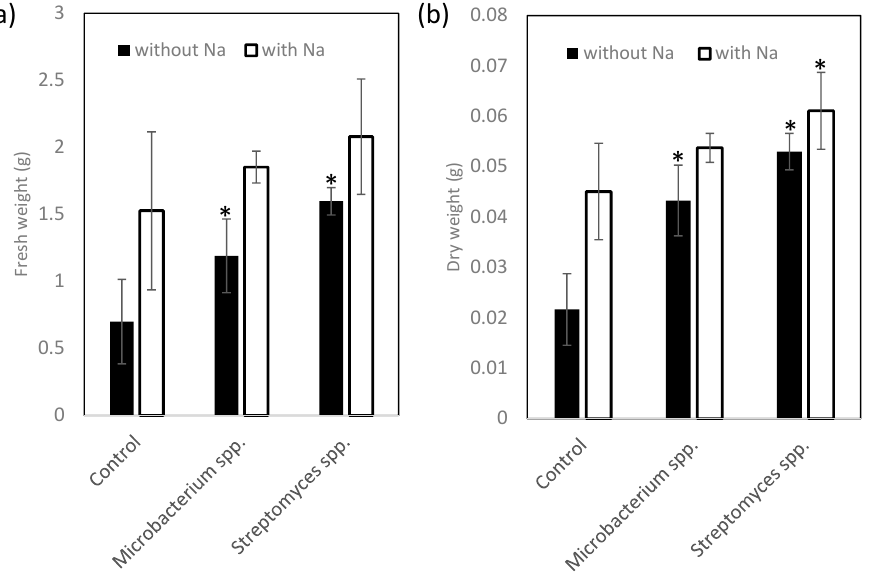
Figure 4. Effect of Streptomyces spp. strains 2 and Microbacterium spp. strain 4 on growth of ice plants in the control (no NaCl) and under 200 mM NaCl. ( a ) Fresh weight and ( b ) dry weight of whole plant. Closed bar indicates 0 mM NaCl, open bar indicates 200 mM NaCl. Values are mean ± standard deviation ( n = 3–6). * Indicates a significant difference between a treatment and control (Dunnett’s test, p < 0.05).